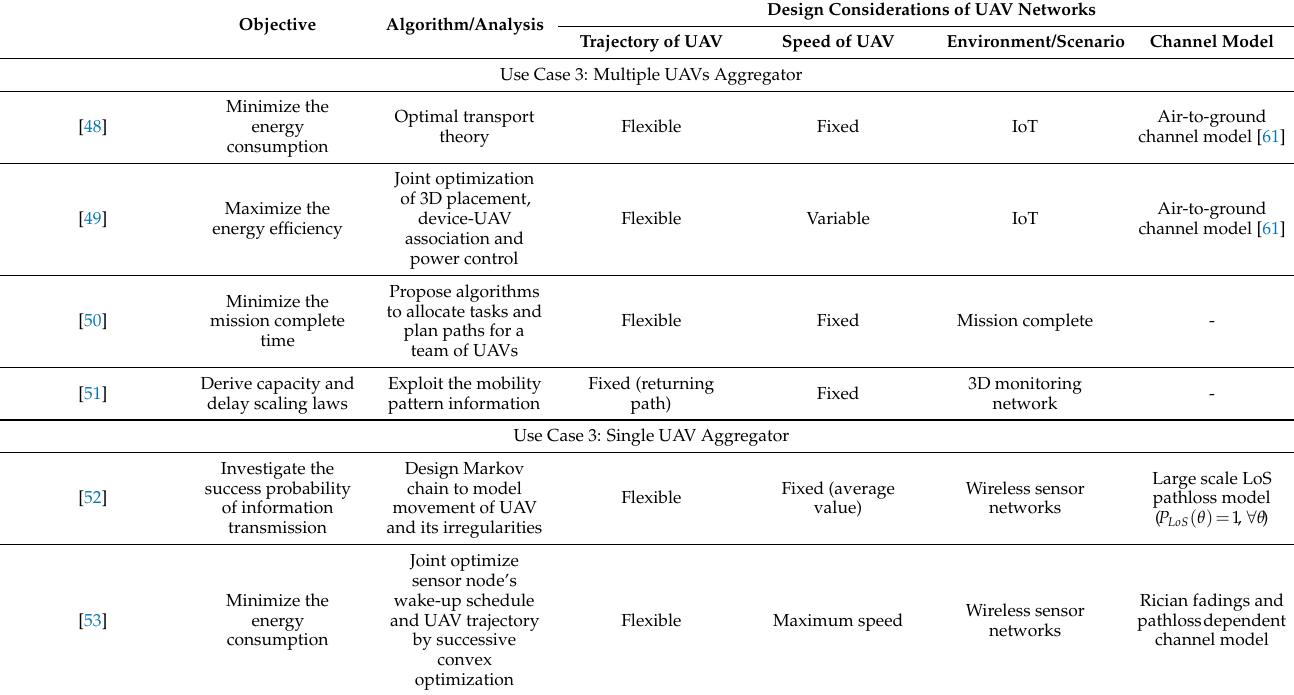
Table 3. Trajectory of mobile